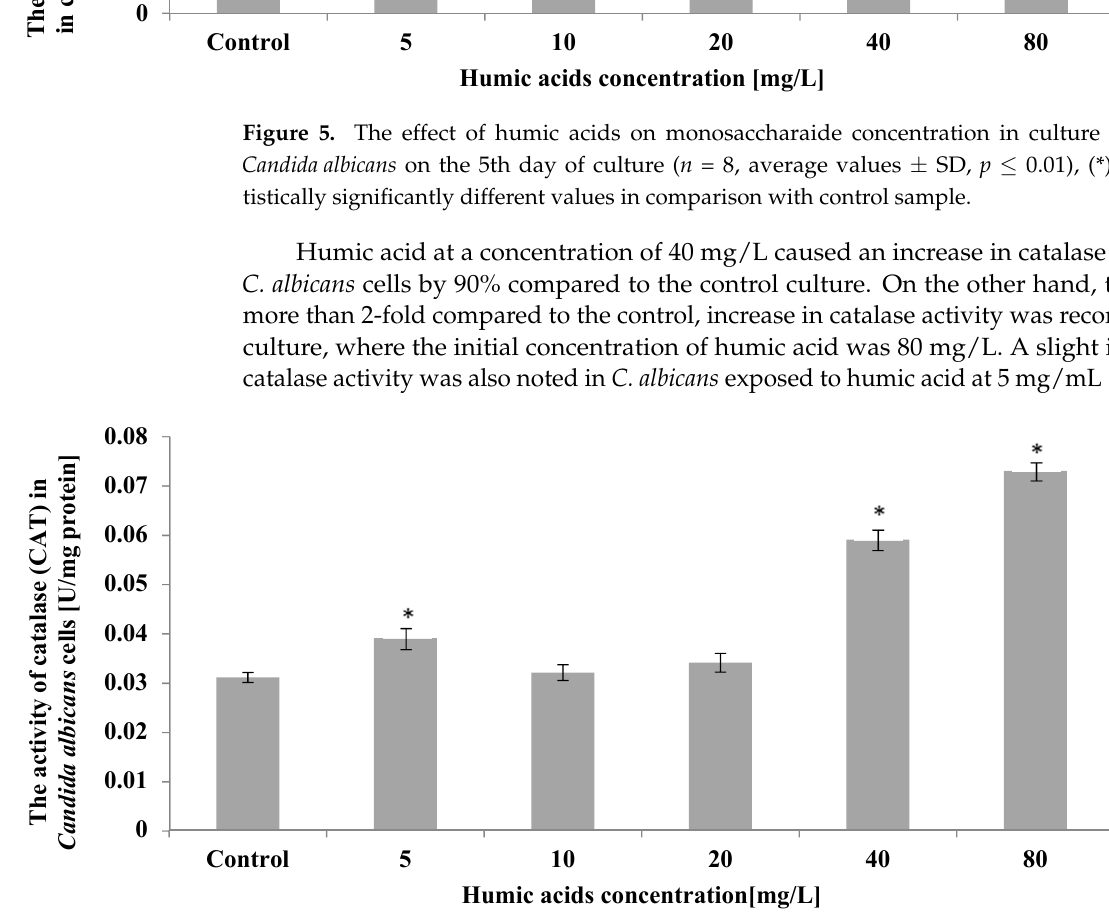
Figure 6. The effect of humic acids on activity of catalase (CAT) in Candida albicans cells on the 5th day of culture ( n = 8, average values ± SD, p ≤ 0.01), (*) shows statistically significantly different values in comparison with control sample.